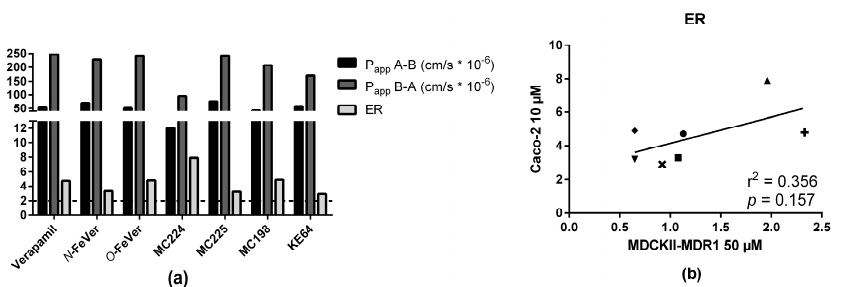
Figure 4. ( a ) Bidirectional transport ( P app and ER) of the test compounds in Caco-2 cells after 2